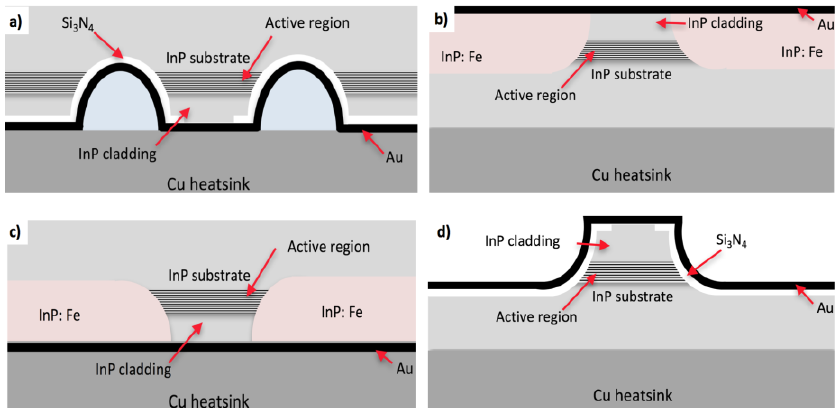
Figure 2. Schematic drawings of lattice matched AlInAs/InGaAs/InP QCL growth by Molecular Beam Epitaxy (MBE) + Metal Organic Vapor Phase Epitaxy (MOVPE) technology, processed in different geometries: ( a ) double trench (DT) mounted epi-layer side down, ( b ) buried heterostructure (BH) mounted epi-layer side up, ( c ) BH mounted epi-layer side down, and ( d ) single mesa geometry (SM) mounted epi-layer side up.